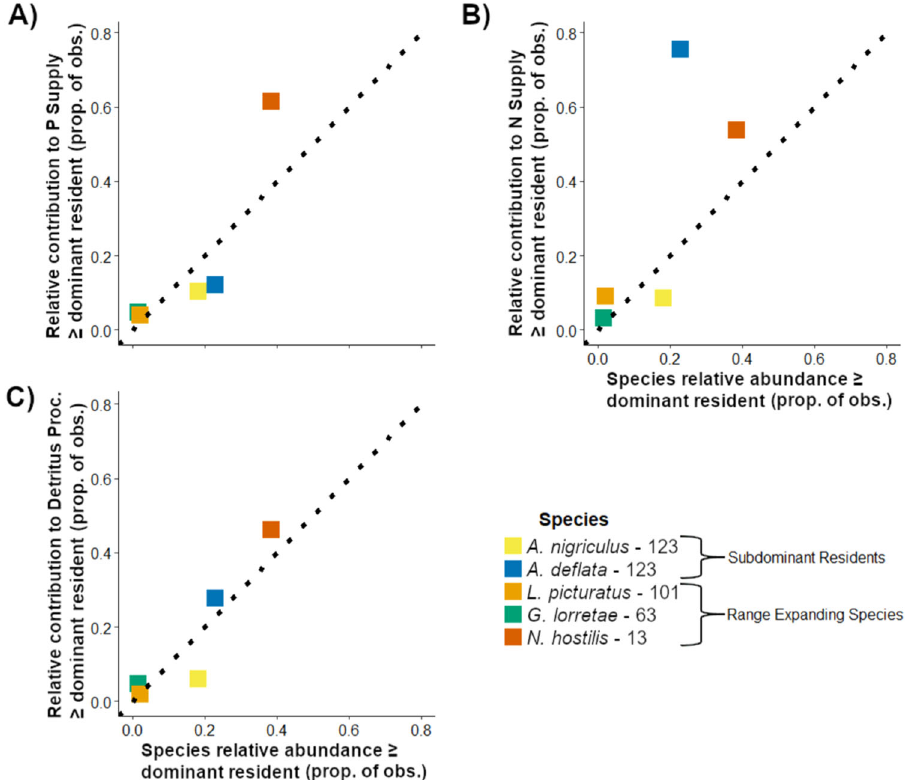
Fig. 3 Proportions of pond-year observations where species ’ relative abundance and contribution to an ecosystem process equaled or exceeded those of dominant resident L. externus . Numeric labels after species names in the legend indicate total number of ponds sampled since the species was fi rst observed at Mexican Cut (e.g., total observations from all ponds across all years). Species above the dotted 1:1 lines can surpass the dominant resident ’ s contribution to ecosystem processes without matching their relative abundance, whereas species below infrequently exceed the dominant resident ’ s contribution despite greater abundance. Comparison of P supply contributions in ( A ), N supply in ( B ), and detritus processing in ( C